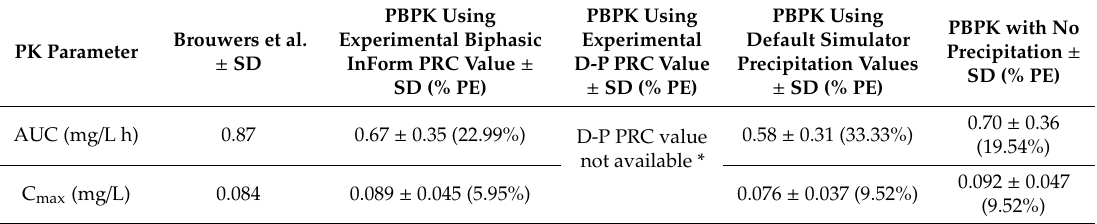
Table 7. Observed and predicted drug exposure pharmacokinetic parameters for 200 mg dose of Sporanox